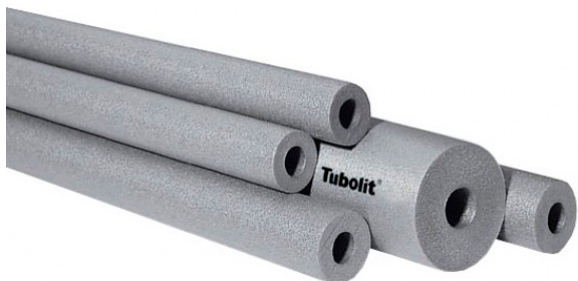
Figure 13. “Mirelon” or “Tubolit” is a brand of polyethylene (PE) foam that has been used as a suitable substitute for steel pipes when measuring an oil coating produced from injected dispersion oil fraction.